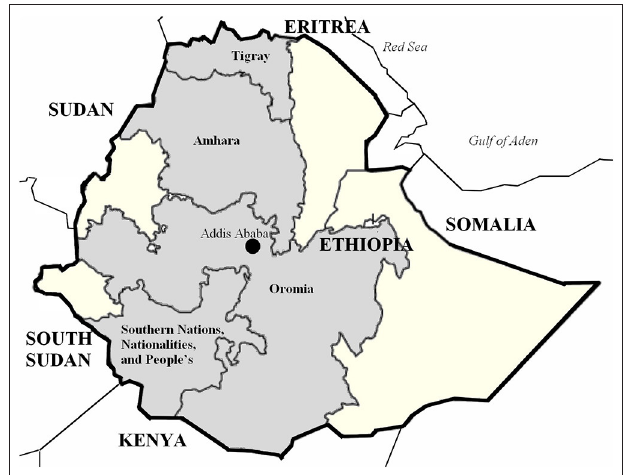
FIGURE 2 | Map of Ethiopia (bold line) and the four regions included in this study (in gray). The capital of Ethiopia, Addis Ababa (black circle), is surrounded by the Oromia